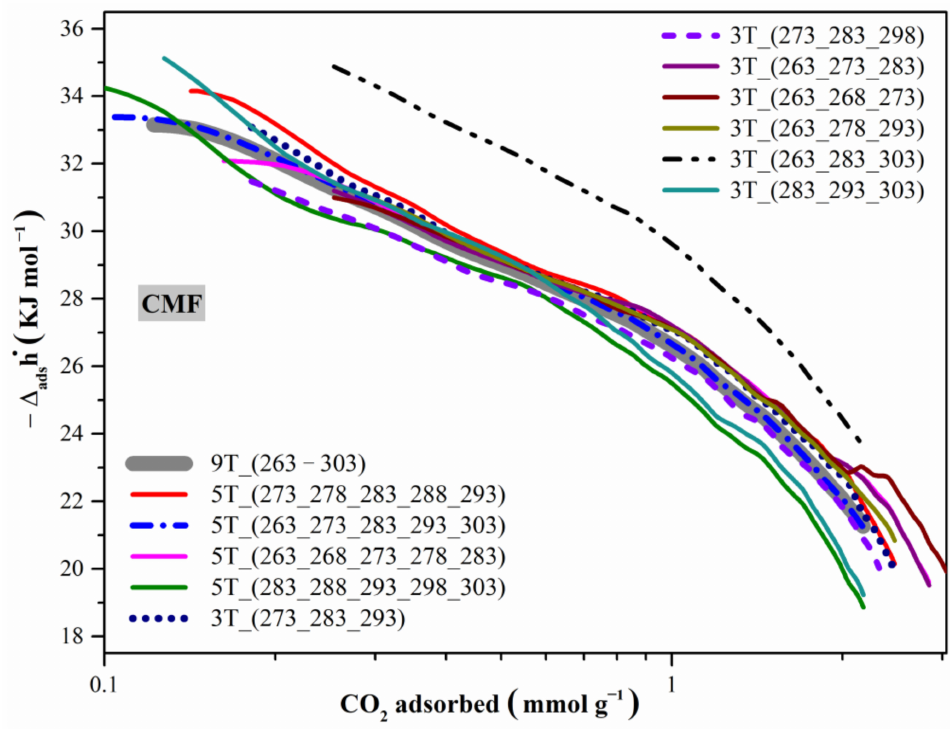
Figure 8. CO 2 isosteric enthalpy of polyacrylonitrile microfibers (PANMF) carbonized at 1223